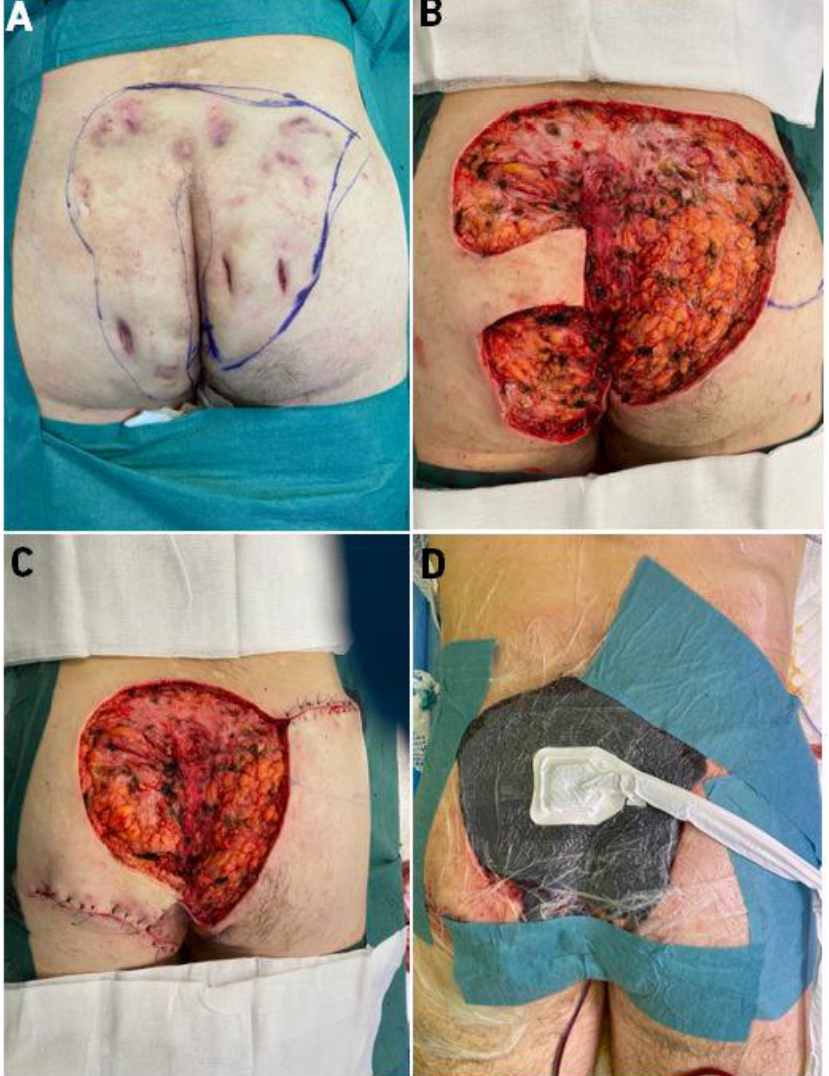
Figure 1. Presentation of Case 1 patient — ( A ) — HS of buttocks before the operation, excision was marked, ( B ) — immediately after excision, ( C ) — local flaps moved to partially close the wound, ( D ) — VAC therapy applied. Legend: HS — Hidradenitis Suppurativa, VAC — Vacuum-Assisted Closure.